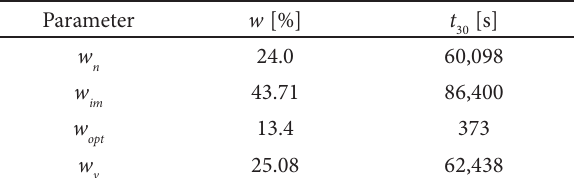
of marl 30 of marsh clay 30